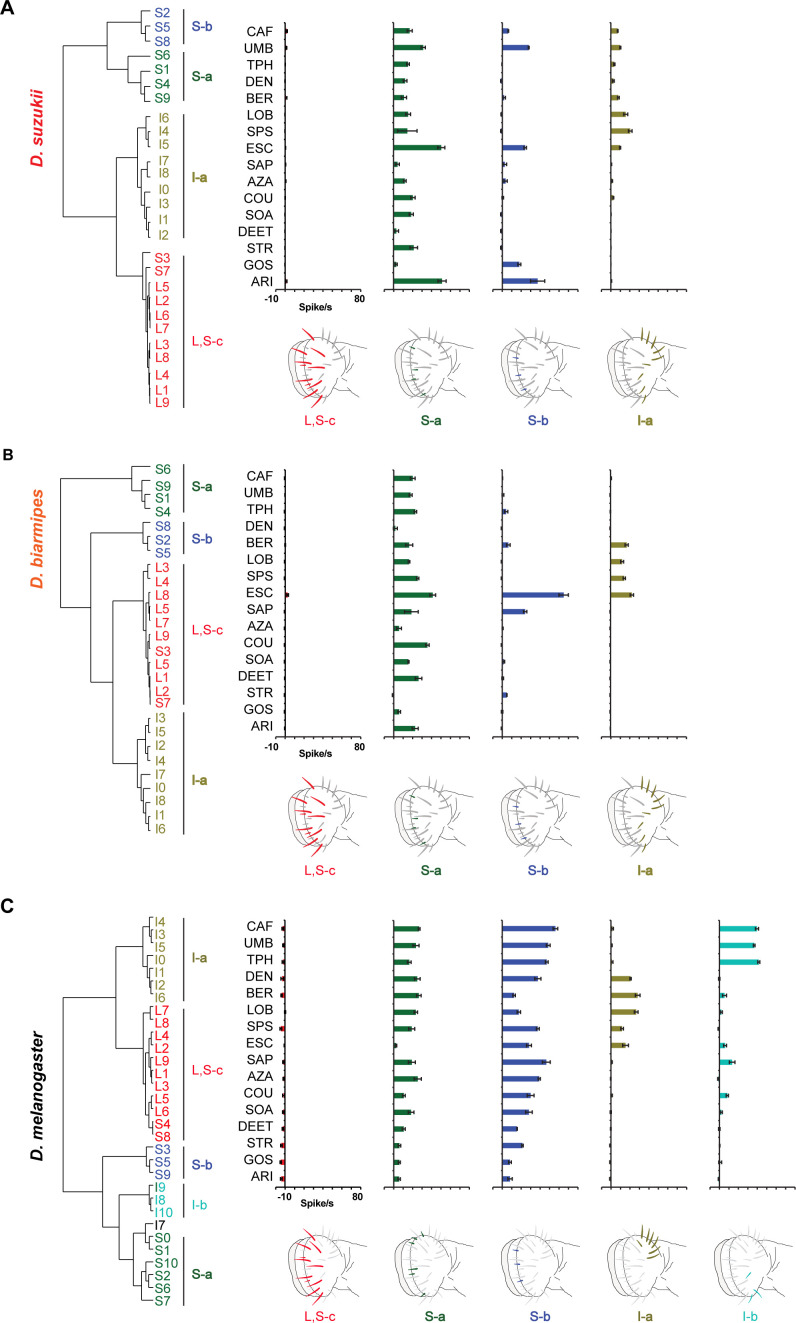
Hierarchical cluster analysis, based on Ward's method, of labellar sensilla in Drosophila suzukii (A), Drosophila biarmipes (B), and Drosophila melanogaster (C).The diluent control was subtracted from each response. Although the S-a and S-b sensilla occupy similar map positions in Drosophila simulans and D. biarmipes, there are two fewer S sensilla in these species than in D. melanogaster and the positions of the remaining S sensilla do not align precisely with those in D. melanogaster; we acknowledge that it is accordingly more difficult to correlate with confidence each S cluster of D. melanogaster with a particular S cluster of the other two species. In D. melanogaster, values are taken from Figure 4 and Figure 4—figure supplement 1; data from D. melanogaster are from Weiss et al., 2011.